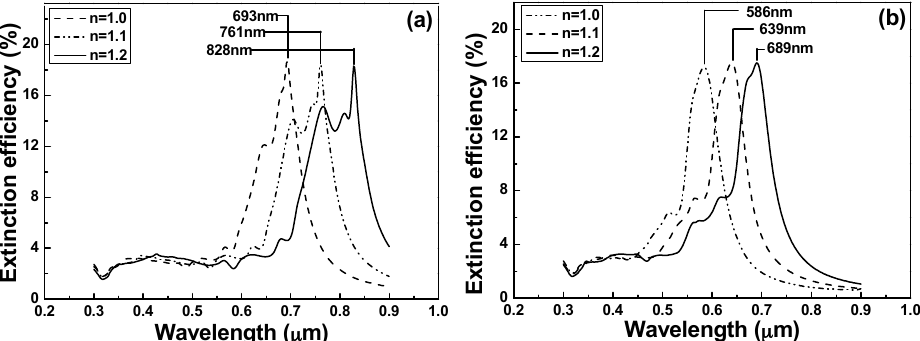
Figure 4. Extinction spectra in different media of nanoparticle arrays for different monome shape: ( a ) hexagonal lattice of triangular; and ( b ) square lattice of quadrate.